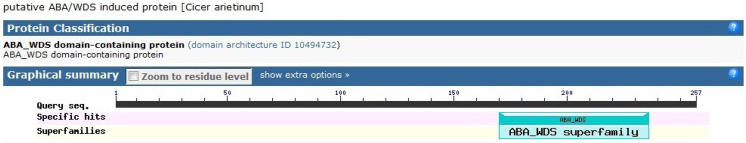
Conserved domains in chickpea ASR gene homologue.NCBI tool for conserved domain search (CDD) identified ABA-WDS domain-containing protein and ABA_WDS superfamily induced by water deficit stress.